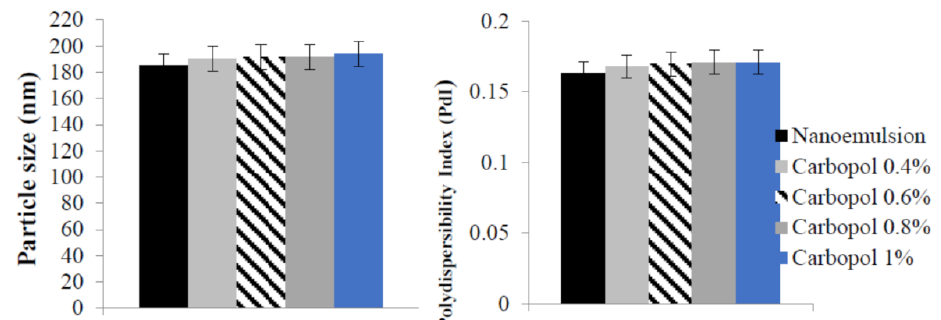
Figure 2. The particle size and polydispersity index (PDI) of Benzoyl peroxide nanoemulgel with different Carbopol concentrations.